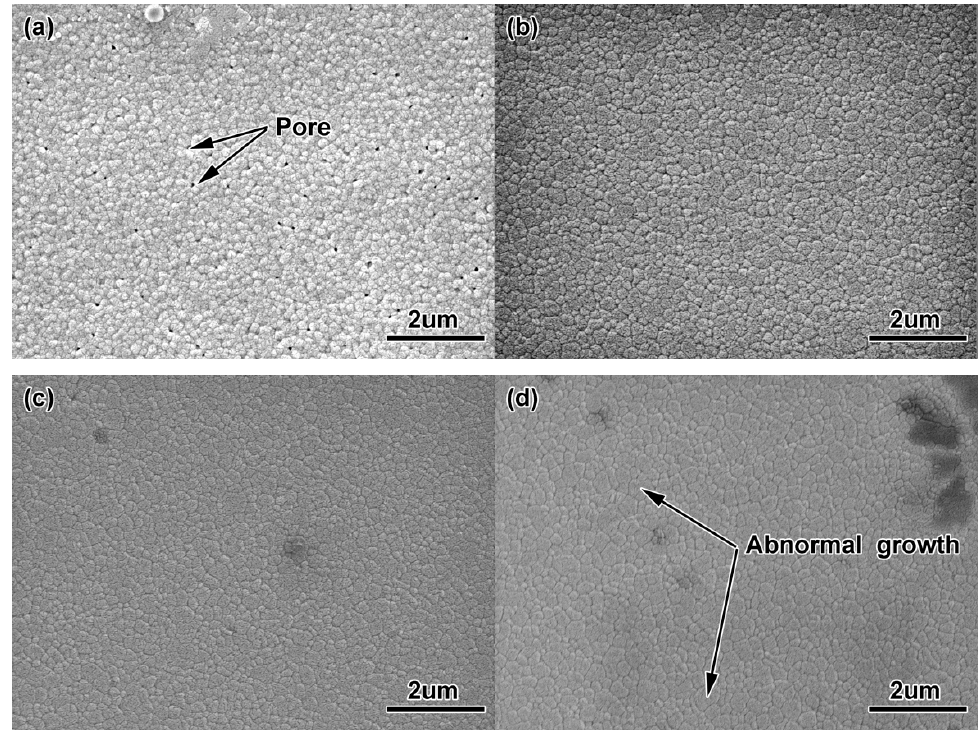
Figure 11. Microstructures of ZrO 2 samples using 100 nm powders sintered at different temperatures ( a ) 1200 ◦ C, ( b )1250 ◦ C, ( c ) 1300 ◦ C, ( d ) 1350 ◦